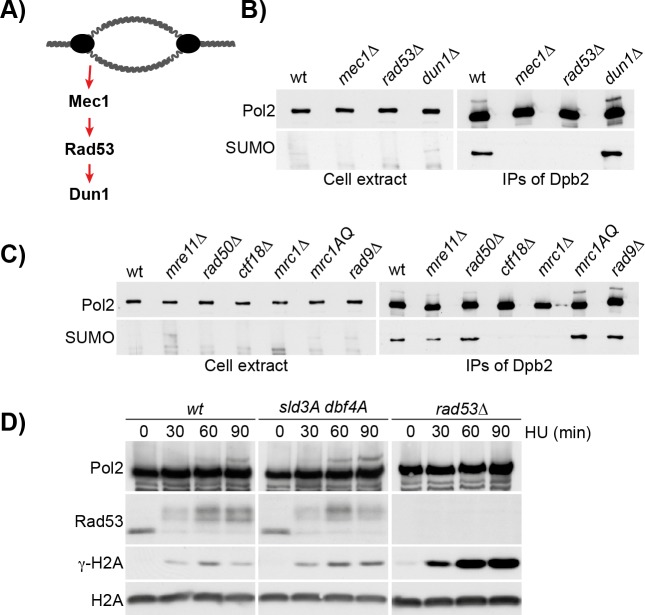
Pol2 SUMOylation depends on Rad53 and S phase checkpoint mediators.A) Representation of the checkpoint kinases cascade. B) Pol2 SUMOylation depends on the checkpoint kinases Mec1 and Rad53. Strains sml1Δ (WT), sml1Δ mec1Δ (mec1Δ), sml1Δ rad53Δ (rad53Δ) and sml1Δ dun1Δ (dun1Δ), all carrying a TAP-tagged version of DPB2, were grown to the exponential phase, arrested in G1 and synchronously released in medium containing 0.2 M HU for 90 min. Dpb2 was immunoprecipitated and the protein samples were analysed by immunoblotting. C) Pol2 SUMOylation depends on the S phase checkpoint mediators Mrc1 and Ctf18. Strains deleted for genes required for the activation of Rad53 in response to double strand breaks (mre11Δ, rad50Δ), to replication stress, either through the S phase checkpoint (mrc1Δ, ctf18Δ, mrc1-AQ), or the DNA damage checkpoint (rad9Δ), were grown to the exponential phase, arrested in G1 and synchronously released in medium containing 0.2 M HU for 90 min. Pol ε was immunoprecipitated via Dpb2-TAP and analysed by immunoblotting. D) Analysis of the kinetics of Pol2 SUMOylation. Wild type cells, mutants sld3-37A dbf4-4A, and sml1Δ rad53Δ were grown to the exponential phase, arrested in G1 and synchronously released in medium containing 0.2 M HU for 90 min. Cells were collected every 30 min, and proteins were analysed by TCA extraction and immunoblotting. Pol2 SUMOylation appears after Rad53 activation and it’s more pronounced in cells defective in the inhibition of late origin firing.